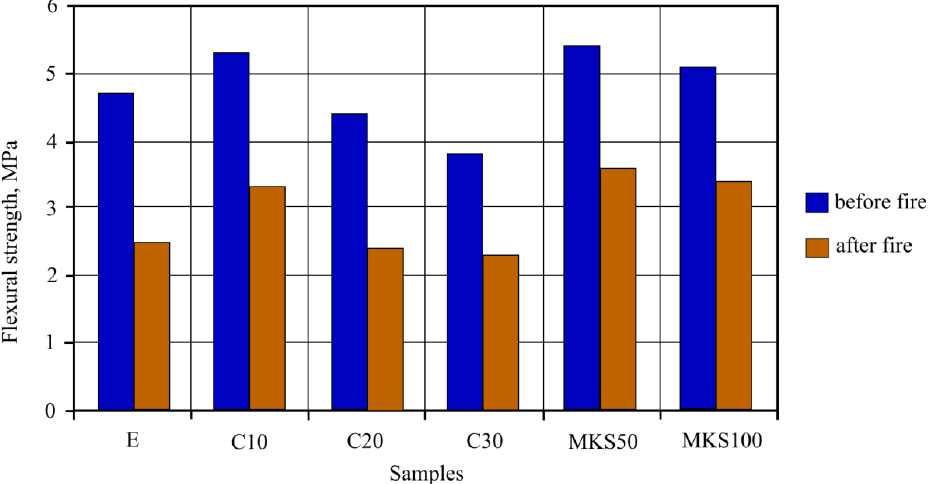
Figure 14. Sample bending strength before and after fire effect results.